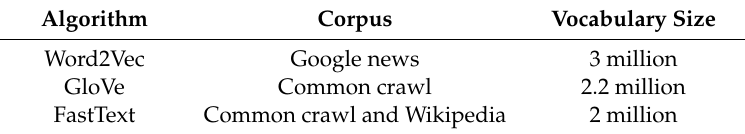
Table 2. Statistic of publicly available pre-trained word embedding models with 300